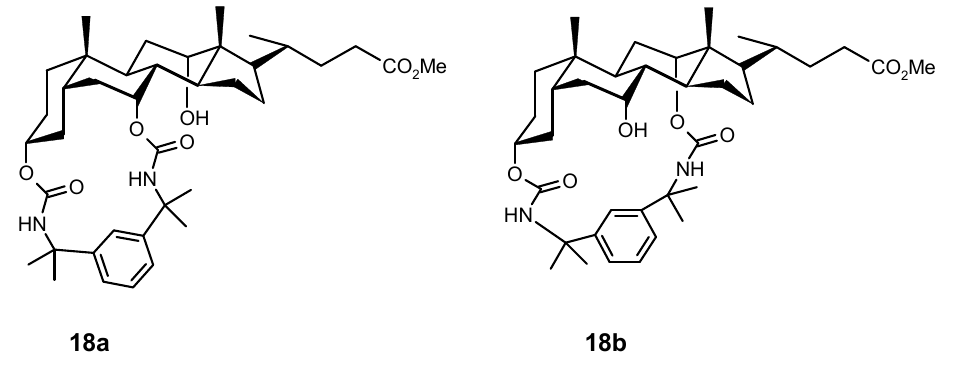
Figure 8. A pair of regioisomeric cyclophanes [92].